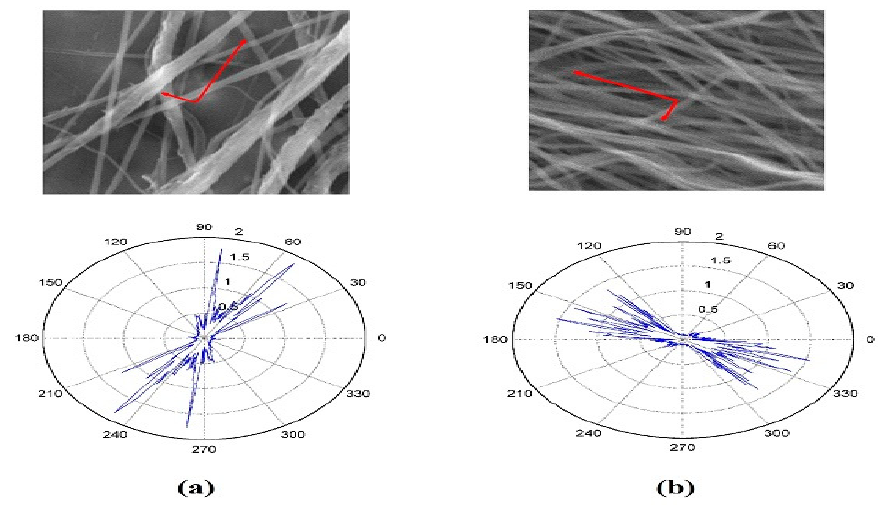
Figure 6. Orientation analysis for nanofibers collected on the 2 bars collector ( a ) PVDF/0.1%CNTs